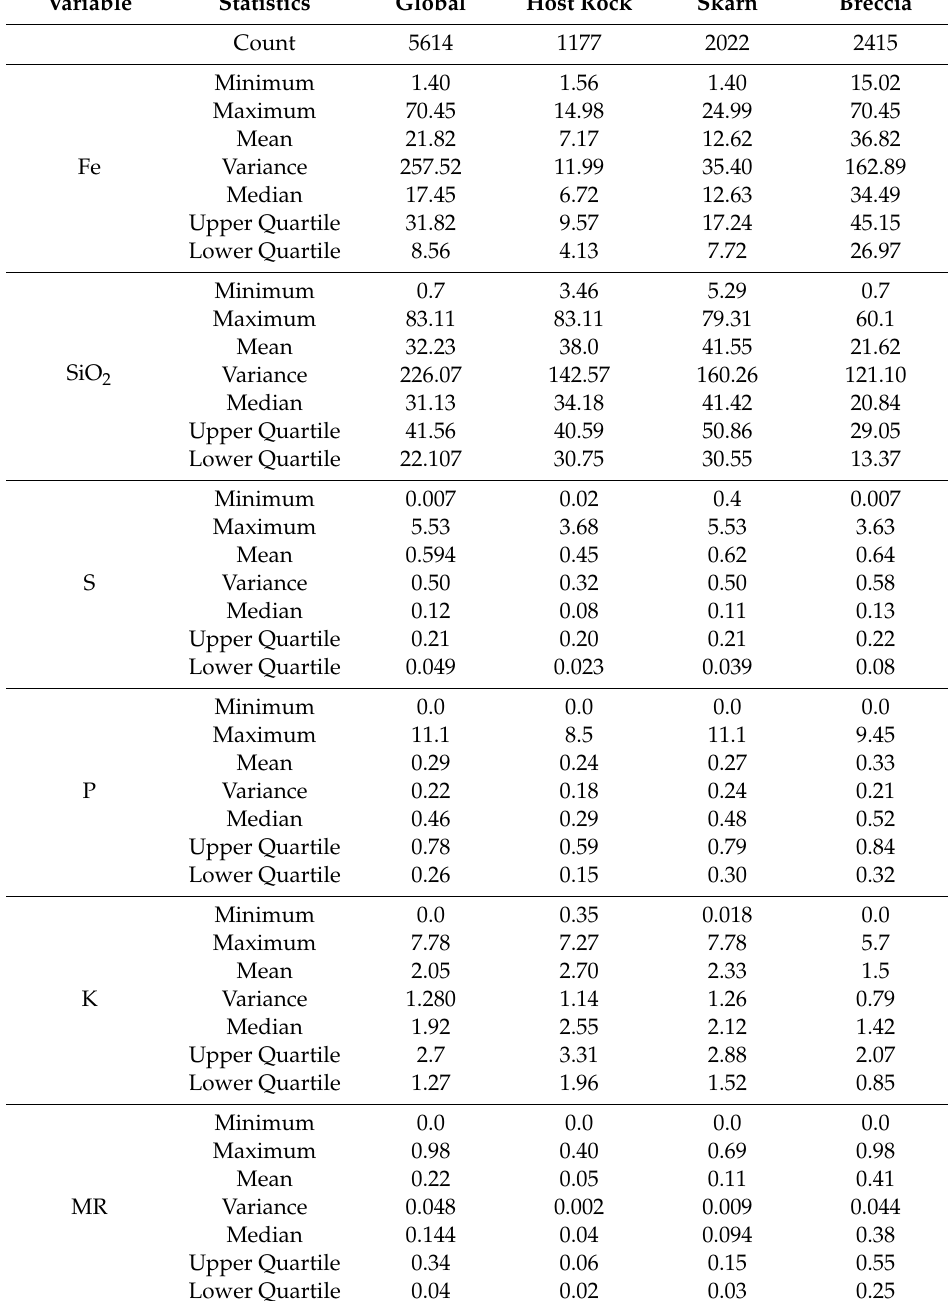
Table 1. Statistics of the quantitative variables, globally and per rock